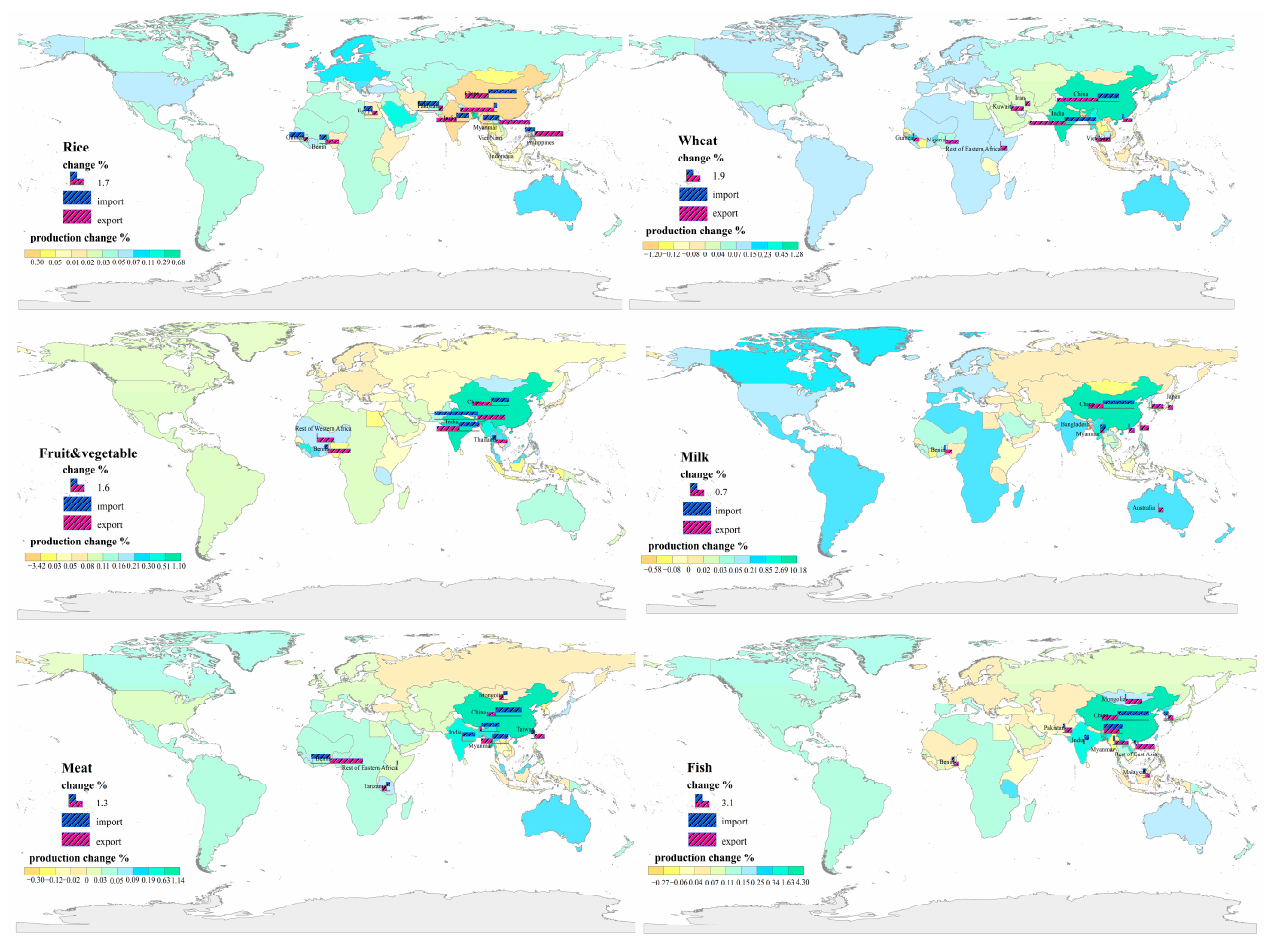
Figure 2. The geographical distribution of production and trade growth rates. Six main food categories, namely rice, wheat, fruits & vegetables, milk, meat, and fish, are presented. The changes in production volume of each category in different regions are indicated by background colors. The most apparent changes in import and export volumes were chosen and are shown in the histograms.